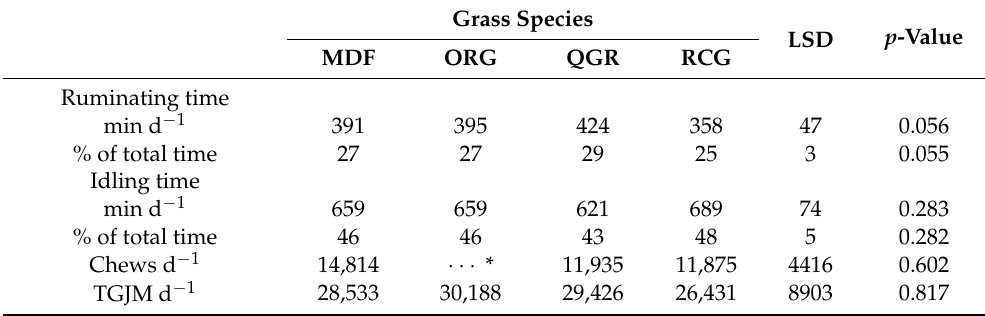
Table 2. Effect of temperate grass species (meadow fescue—MDF; orchardgrass—ORG; quackgrass— QGR; reed canarygrass—RCG) on ruminating time, idling time, number of chews, and total grazing jaw movements (TGJM) of grazing dairy heifers. Means are average of three seasons and two years. Grass Species